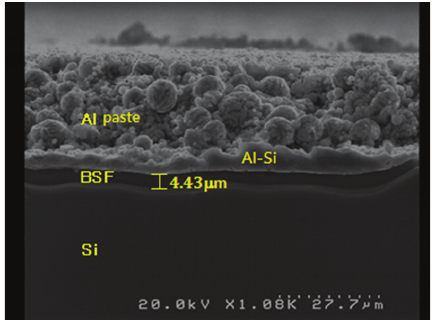
Figure 5: Cross-section of the rear side of the solar cell fabricated in this